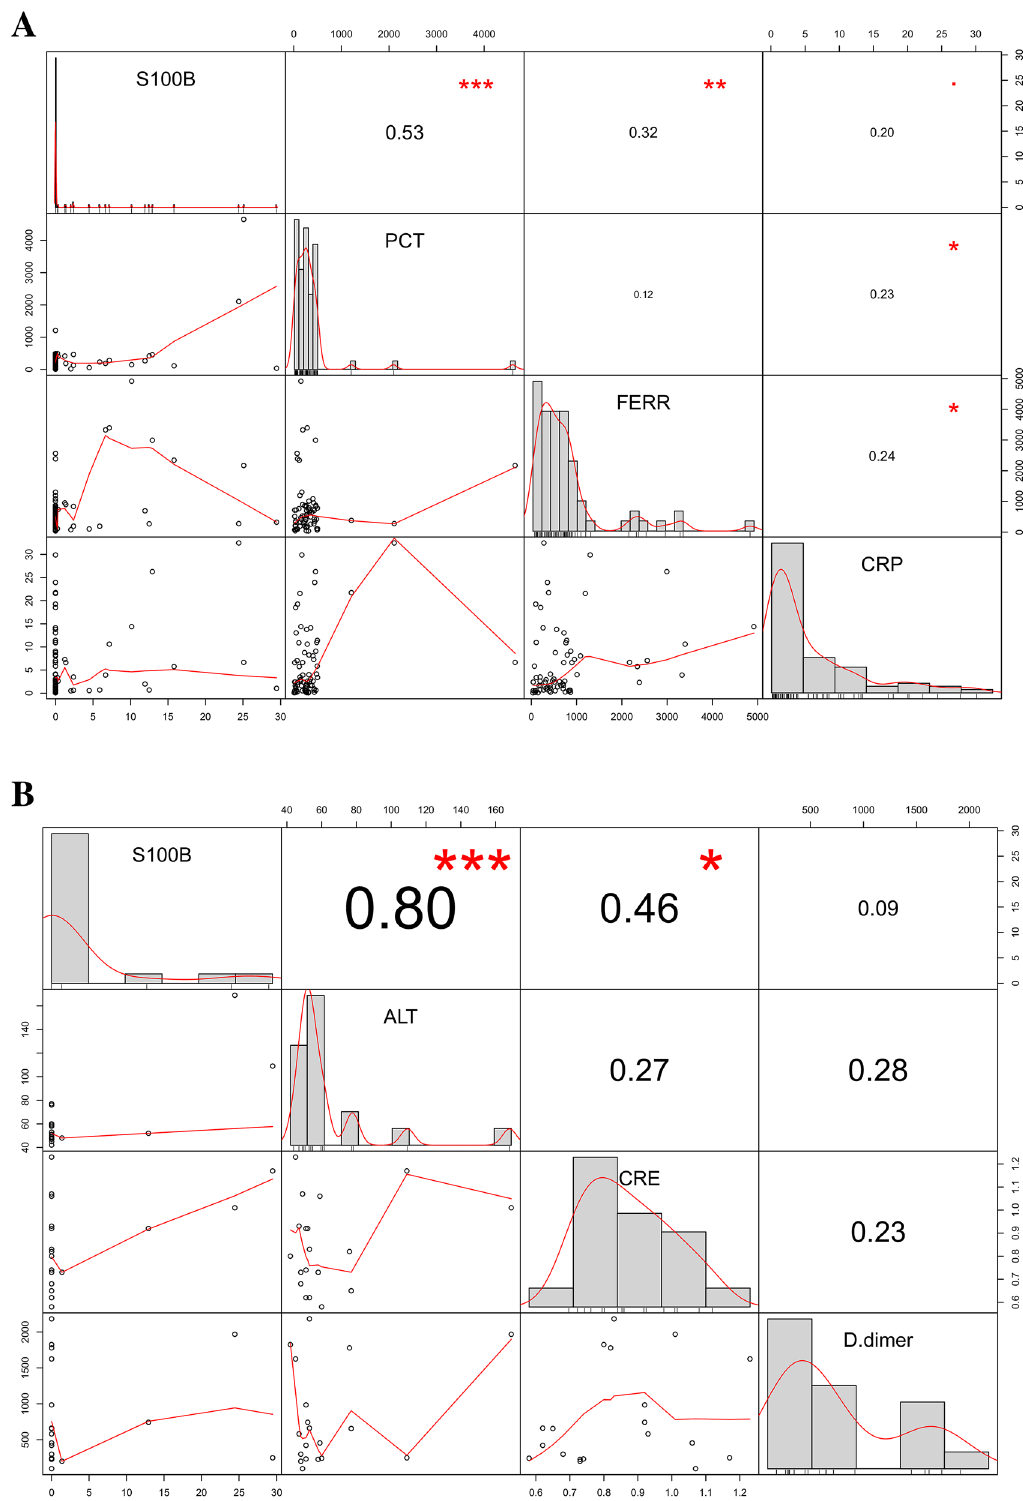
Figure 3. Correlation of S100B with other blood markers. ( A ) Correlation of S100B versus inflammatory markers. S100B significantly correlates with PCT, FERR, CRP. Scatterplots of pairwise variable are shown. Values in the middle of boxes are referred to the Pearson Correlation. PCT: Procalcitonin; FERR: Ferritin, CRP: C-Reactive Protein. Red Stars and dots are referred to the p-values (*** p < 0.0001; ** p < 0.001; * p < 0.01; + p < 0.1). ( B ) Correlation of S100B versus Organ Damage markers. S100B significantly correlates with ALT and CRE (subgroup of patients showing ALT > 40 IU/L). Scatterplots of pairwise variable are shown. Values in the middle of boxes are referred to the Pearson Correlation. ALT: Alanine Aminotransferase; CRE: Creatinine; d-Dimer: d-Dimer. Red Stars and dots are referred to the p values (*** p < 0.0001; ** p < 0.001; * p < 0.01; + p <